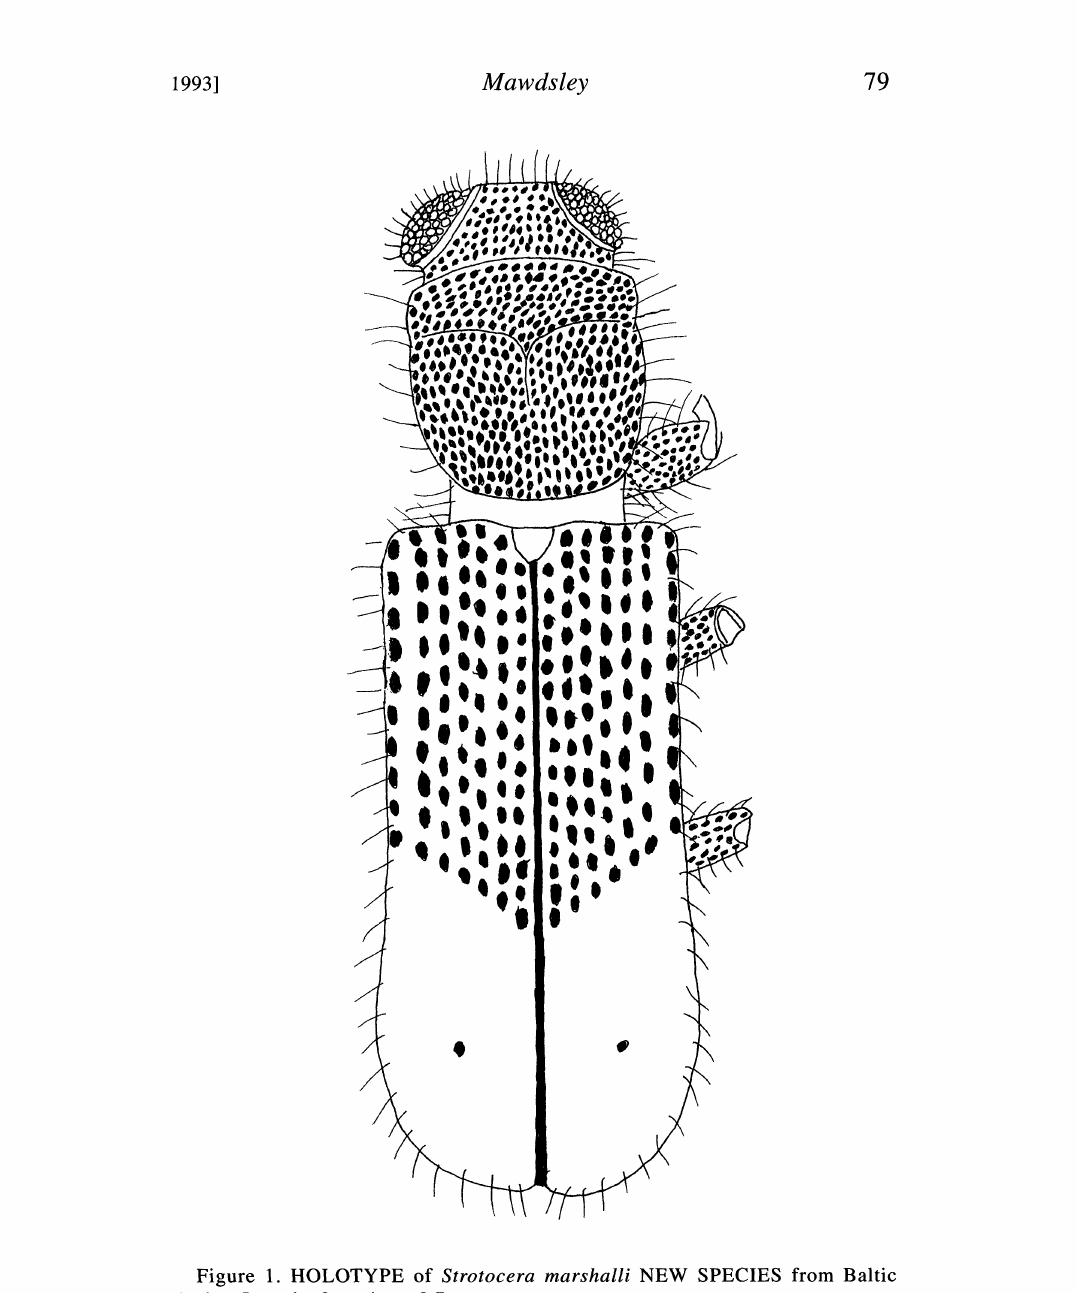
Figure 1. HOLOTYPE of Strotocera marshalli NEW SPECIES from Baltic Amber. Length of specimen 9.7